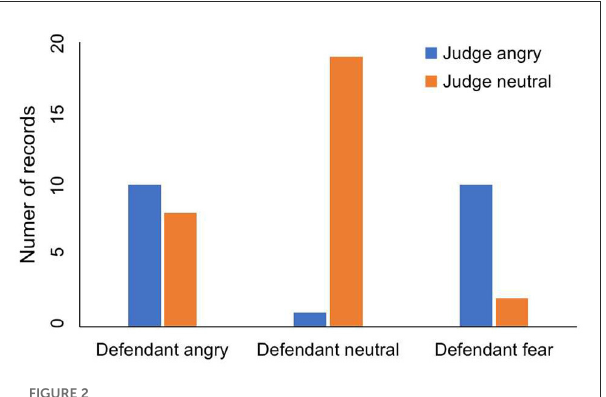
FIGURE2 The influence of judge’s emotion on defendant’s emotion.